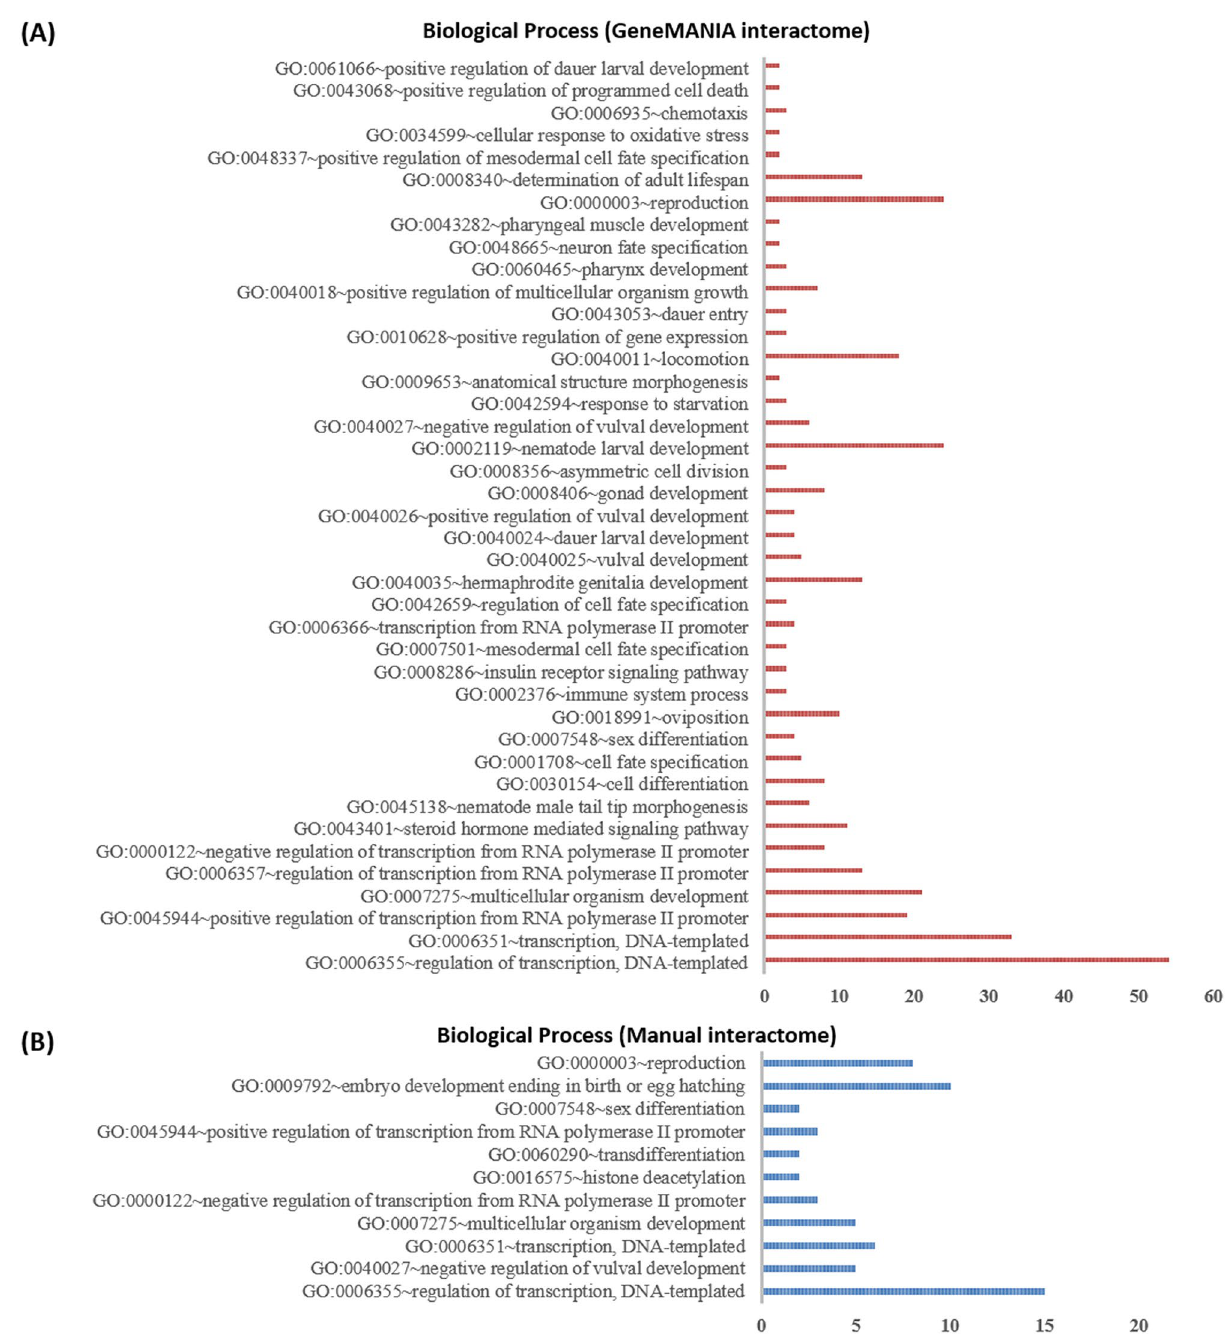
Figure 4. Biological processes associated with protein interactome of C. elegans SIN-3 protein, obtained from ( A ) GeneMANIA database and ( B ) Direct Evidence method using the NIH LHRI DAVID 6.8 service. In order to find reliable protein–protein interactions , experimental evidence was analyzed along with the GeneMANIA dataset via literature based evidence method. The y-axis represents the GO biological processes, while the x-axis represents the number of proteins associated with a particular biological